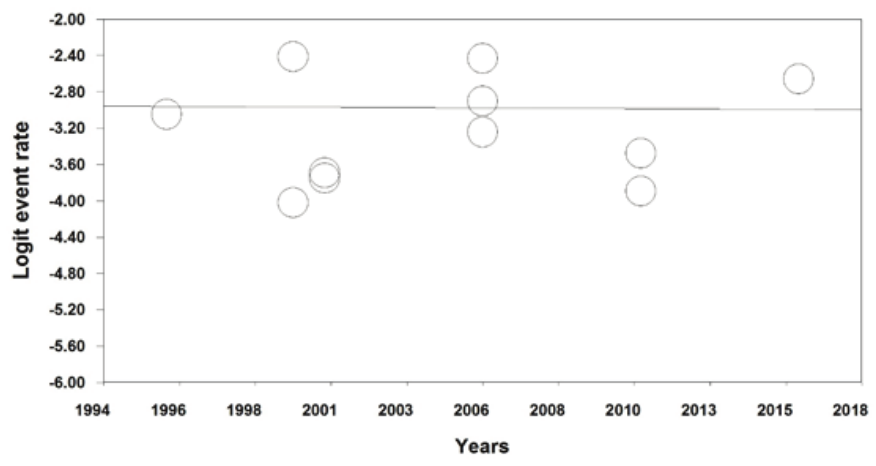
Figure 9. Heterogeneity check diagram of the color blindness by the year of research.